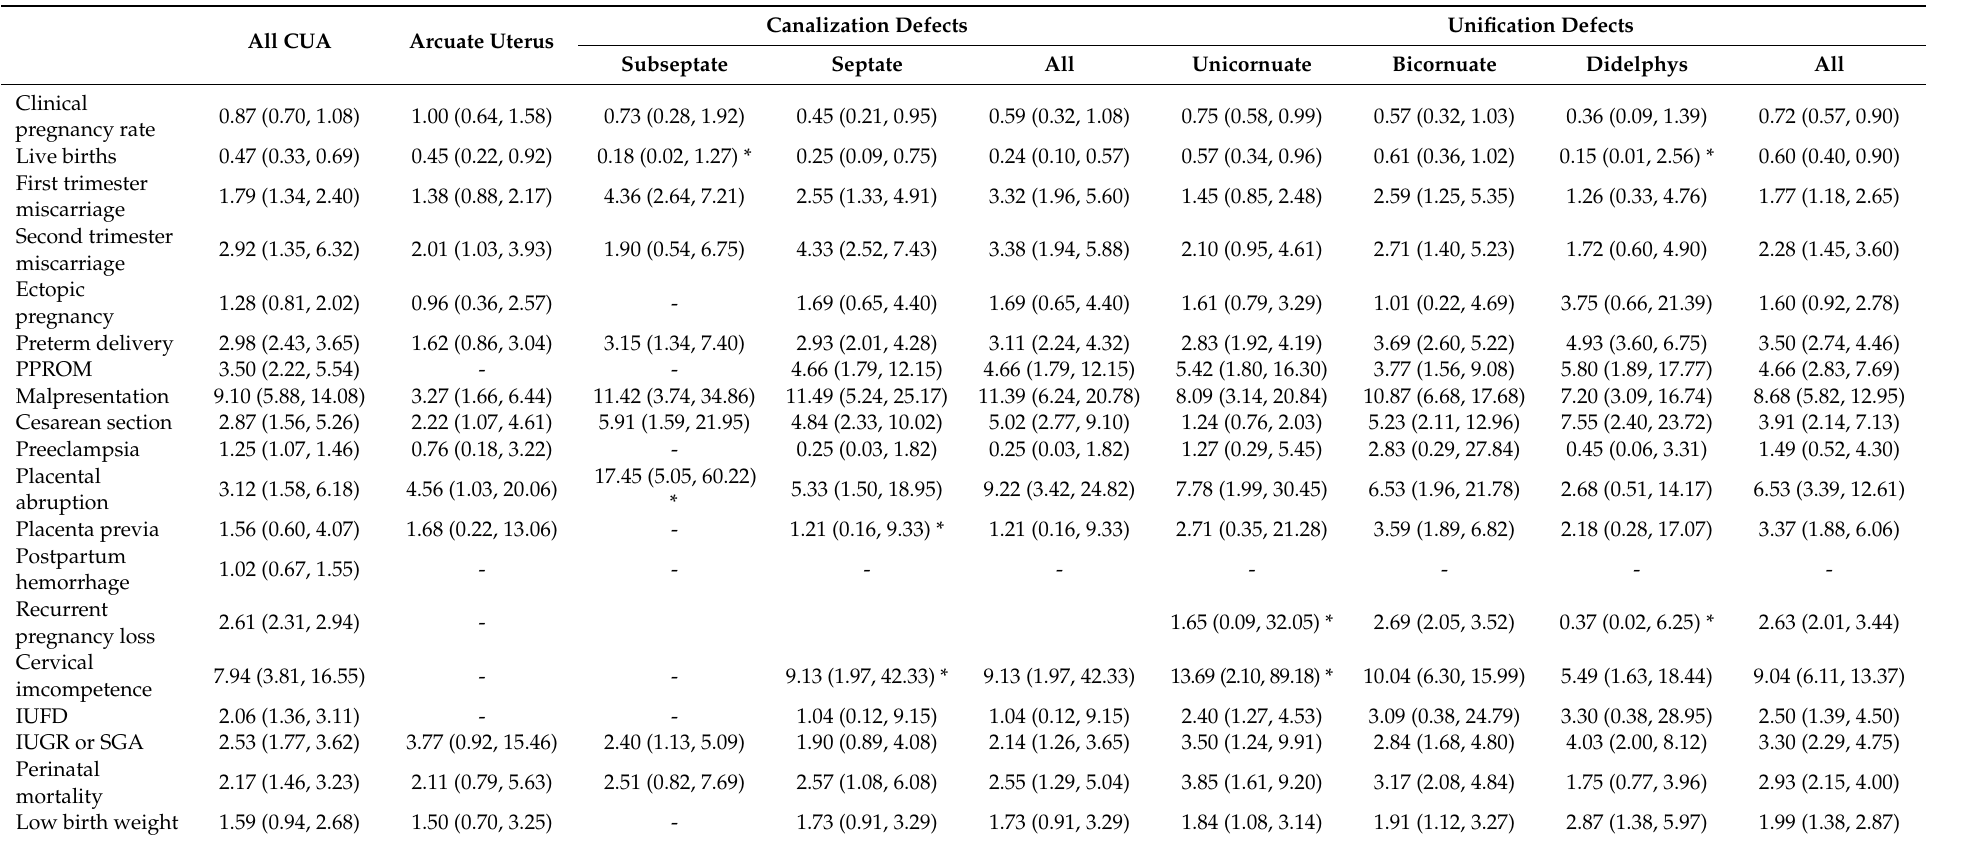
Table 2. Reproductive, obstetric, and neonatal outcomes according to the subtype of congenital uterine